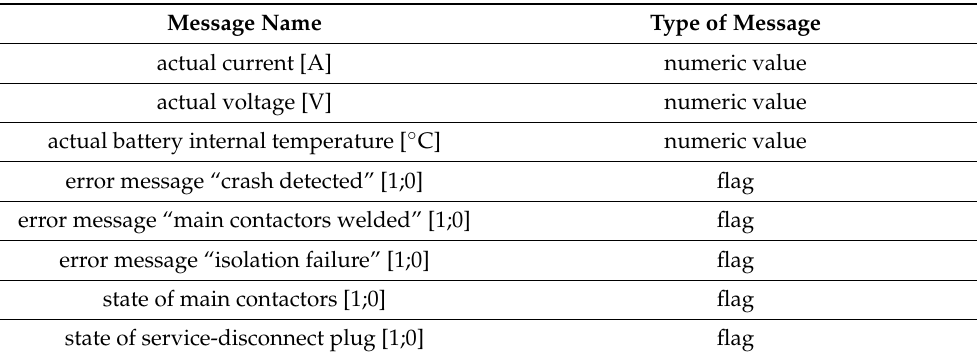
Table 5. Selected CAN-messages available at BMS data-port of example battery